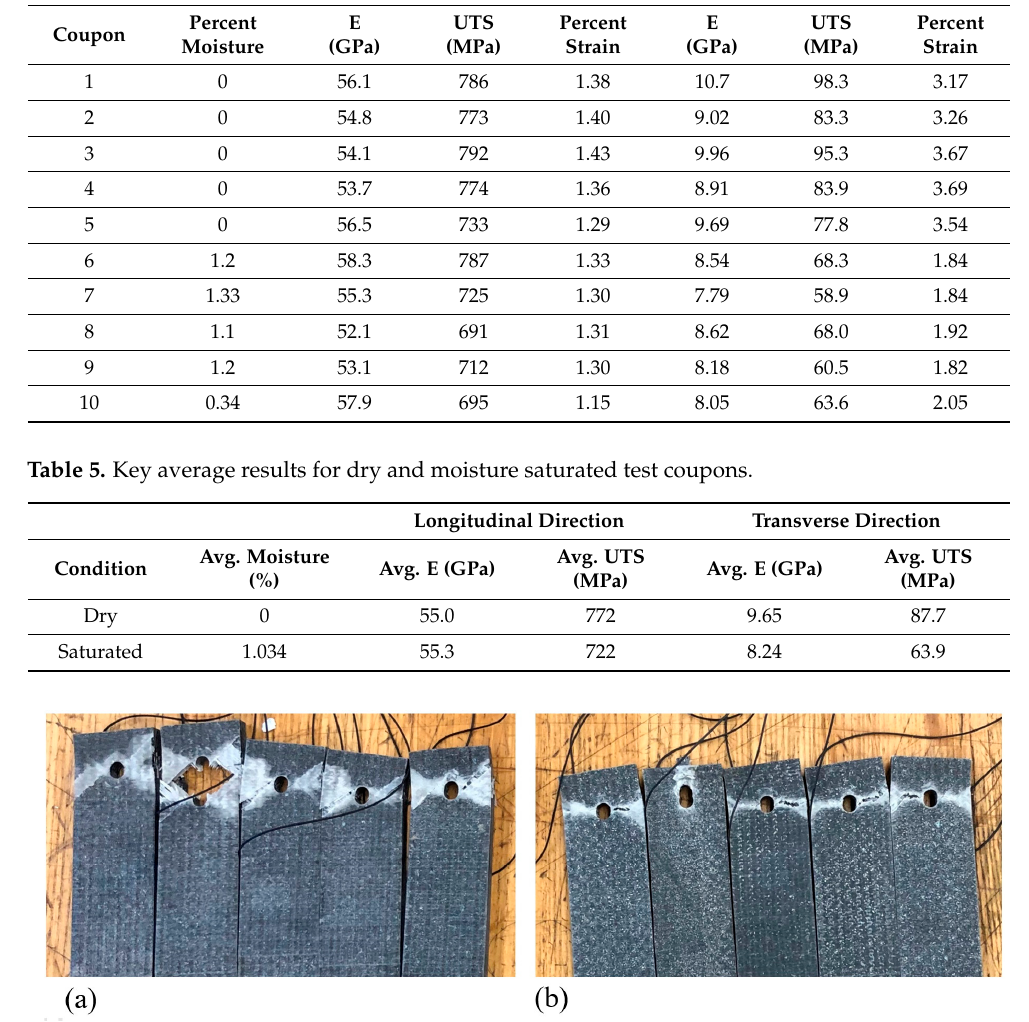
Table 5. Key average results for dry and moisture saturated test coupons.